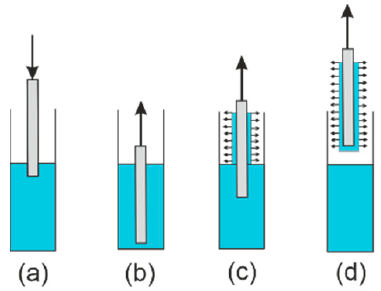
Figure 2. The stages of dip-coating technique. ( a ) Dipping the substrate in the sol, ( b ) beginning of the withdrawal, ( c ) withdrawal of the substrate from the sol, ( d ) pre-drying the layer.